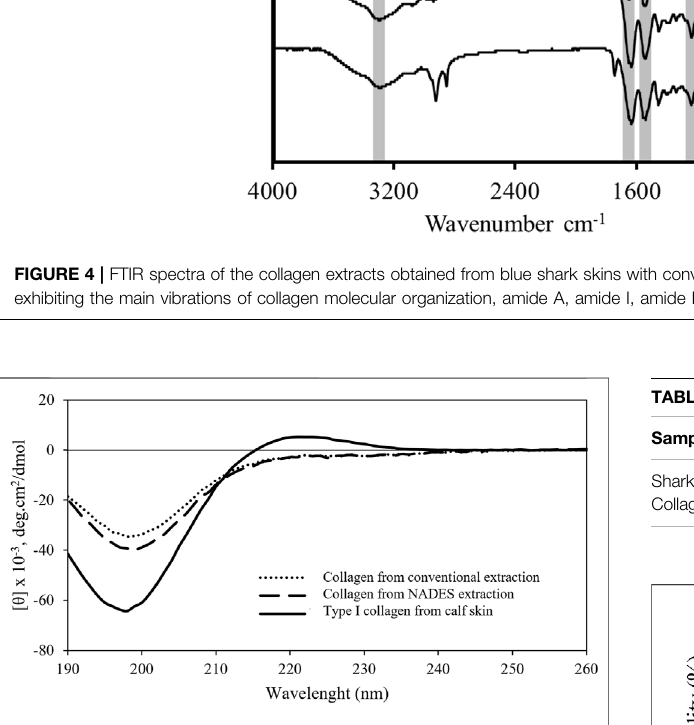
FIGURE 5 | CD spectra of the collagen extracts obtained from blue shark skins with conventional solvent and NADES and type I collagen standard from calf skin.